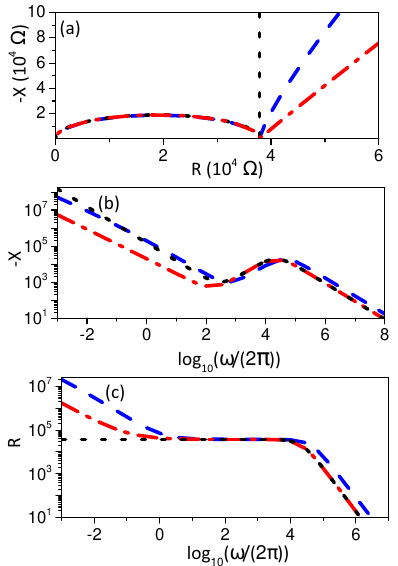
Figure 4. ( a ) Nyquist diagram, ( b ) the imaginary, and ( c ) real parts of the impedance obtained from Equation (48) for different values of γ and α , with Φ ( i ω ) = p ( i ω ) + ( 1 − p )( i ω ) γ (with p = const ) and k ( i ω ) = κ ( i ω ) α (with κ = const ). The black (dotted), red (dashed-dotted), and blue (dashed) lines correspond to the cases γ = 1.0 with k ( i ω ) = 0, γ = 1.0 with k ( i ω ) (cid:54) = 0 (with α = 0.8), and γ = 0.7 (with p = 1/2) and k ( i ω ) = 0, respectively. We consider, for illustrative purposes, D = 2.0 × 10 − 9 m 2 /s, S = 3.14 × 10 − 4 m 2 , ε = 90 ε 0 ( ε 0 = 8.85 × 10 − 12 F/m), d = 1.33 × 10 − 3 m, τ = 1s, κ = 1.11 × 10 − 6 m/s 1 − α , and λ = 1.19 × 10 − 7